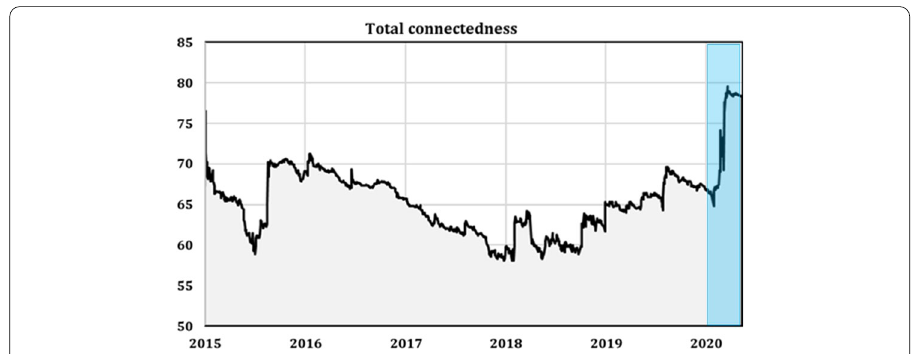
Fig. 2 Total connectedness measure (the shaded blue area indicates the period of the COVID-19